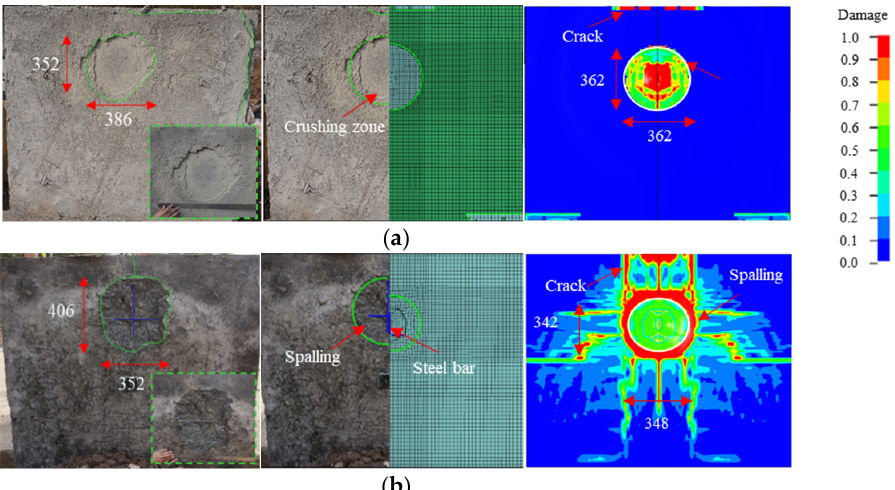
Figure 11. Experimental and simulation results for the damage of the 10 mm FC + SW wall (unit: mm): ( a ) Front side; ( b ) Back side. ( a ) Front side; ( b ) Back